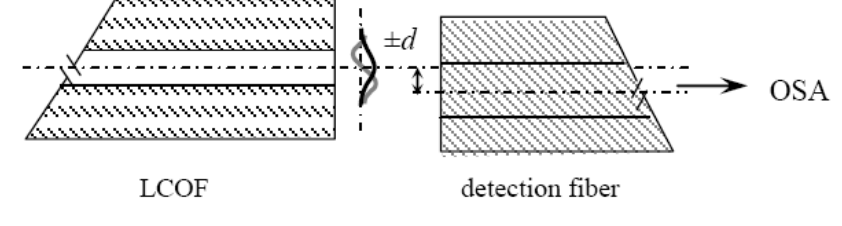
Figure 2. Experimental arrangement for detection of intermodal interference of the modes LP and LP in the LCOF. 01 11